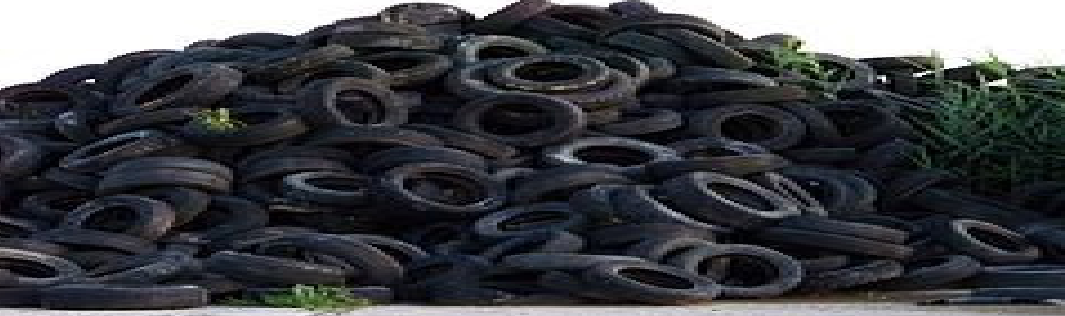
Fig. 2: Vulcanizing Used tyre dumpsite